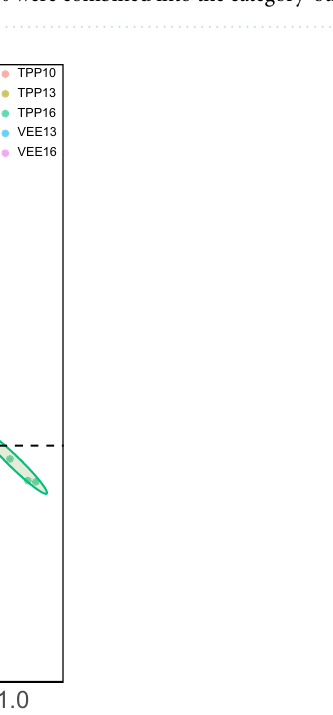
Figure 3. Analysis of the soil fungal community structure and composition in plots subjected to different planting systems. ( A ) Community structure and composition at the phylum level; ( B ) community structure and composition at the genus level. Taxa with an abundance of less than 1% were combined into the category ‘other’.